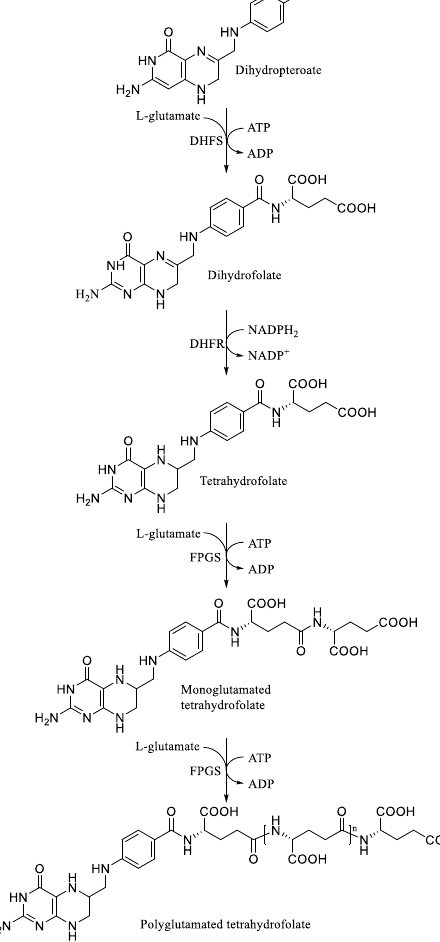
Figure 1. Activities of dihydrofolate synthetase (DHFS) and folylpolyglutamate synthetase (FPGS) in folate metabolism.